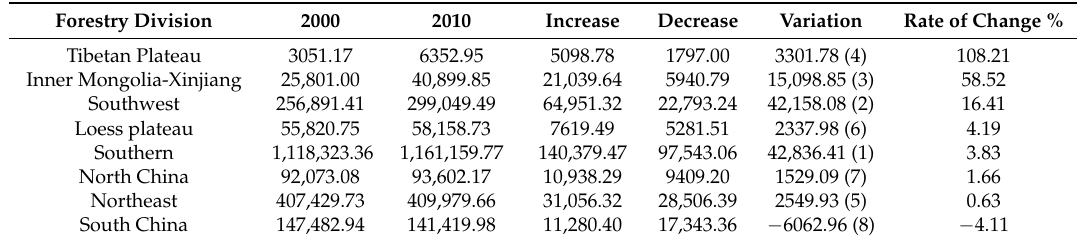
Table 2. Changes in forest area in eight forest districts, 2000–2010 (km 2 ).